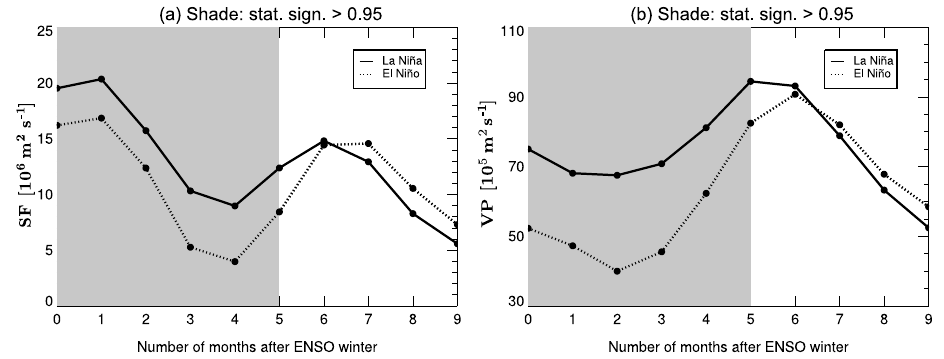
Figure 4. The average value of the stream function (a) in the domain of 0 ◦ –35 ◦ N, 0 ◦ –160 ◦ W and velocity potential (b) in the domain of 30 ◦ S–40 ◦ N, 90 ◦ E–140 ◦ W for La Niña (solid line) and El Niño (dotted line) composites at θ = 380K. The grey shading region denotes the period with statistically significant differences between the two